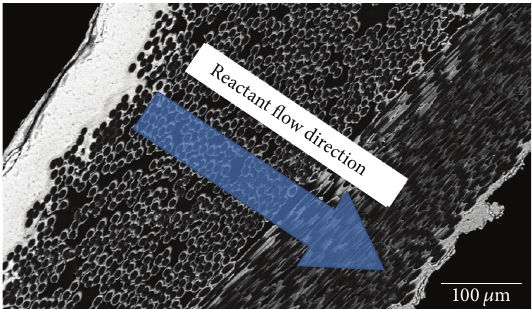
Figure 4: SiC build-up on the upstream side of the sample caused by increasing reactant pressure and varying deposition conditions on the upstream side of the sample during